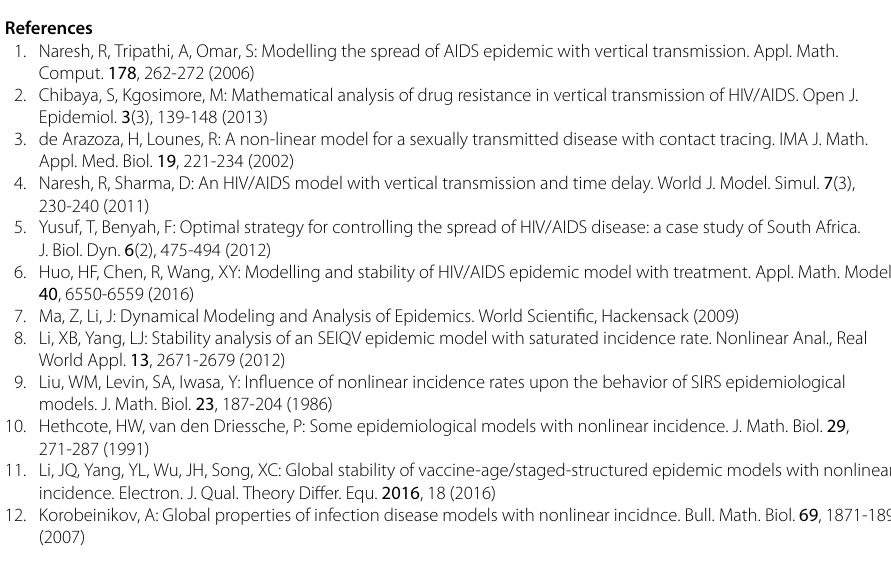
determined by the basic reproduction number (cid:2)  . When (cid:2)  is less than unity, the disease- free equilibrium is globally asymptotically stable. When (cid:2)  is bigger than , the unique endemic equilibrium is globally asymptotically stable under the condition μ  < k  + k  . Our results suggest that appreciable change in the susceptible individuals’ sexual habits faster reduces both incidence and prevalence the disease. Numerical simulations are given to support our analytic